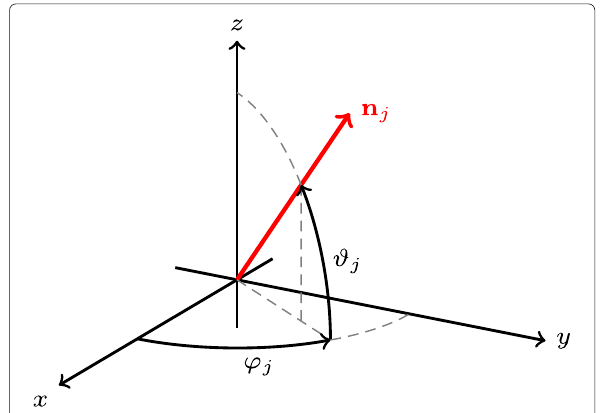
Fig. 1 Definition of the azimuth and elevation angles of arrival, ϕ j and ϑ j , as well as the corresponding DOA vector n